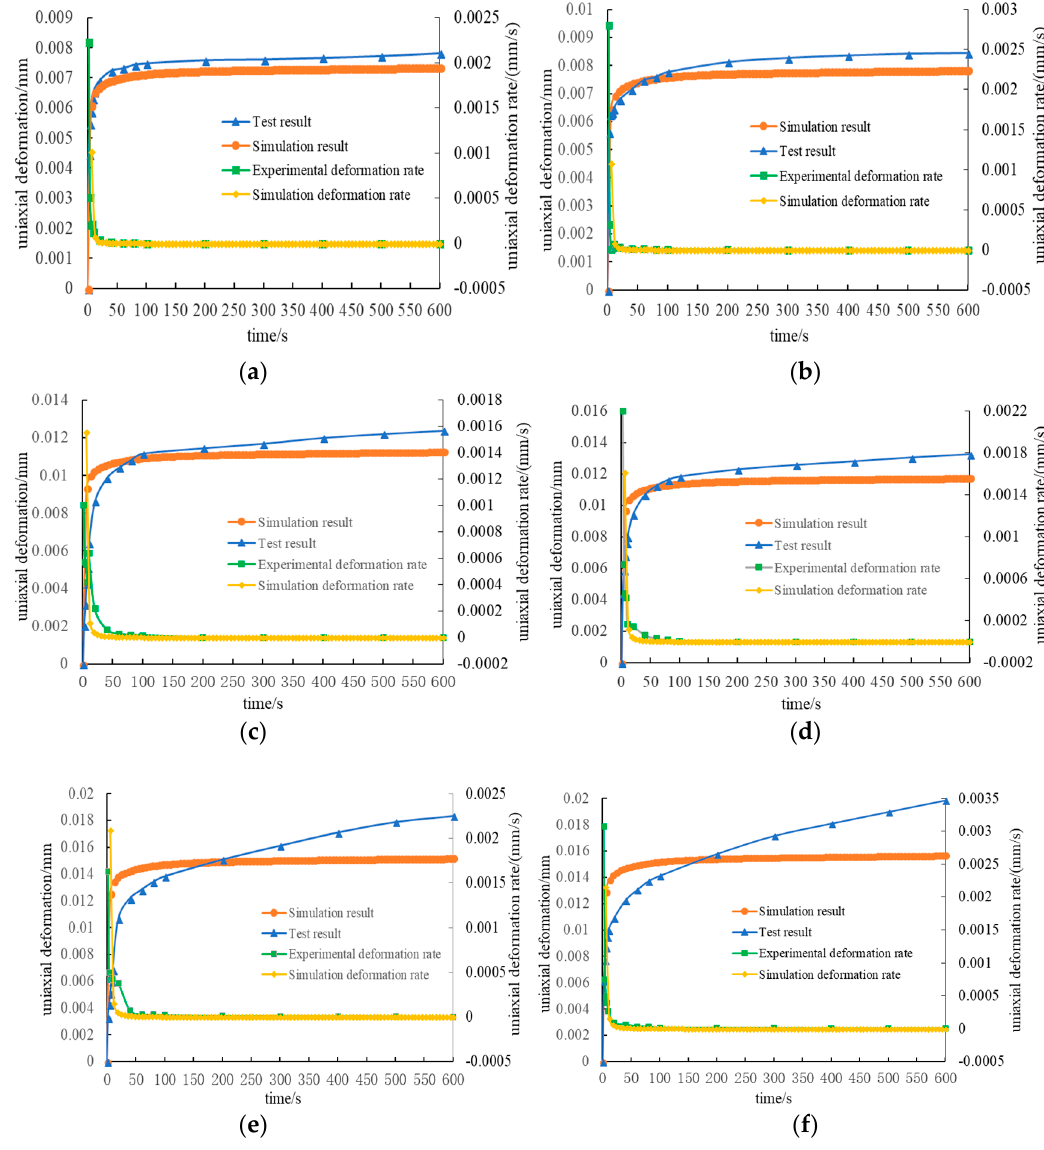
Figure 12. Experimental and simulation results of axial creep deformation under different loading conditions: ( a ) with 60 kPa confining pressure and 80 kPa axial loading; ( b ) without confining pressure and with 80 kPa axial loading; ( c ) with 60 kPa confining pressure and 120 kPa axial loading; ( d ) without confining pressure and with 120 kPa axial loading; ( e ) with 60 kPa confining pressure and 160 kPa axial loading; ( f ) without confining pressure and with 160 kPa axial loading.